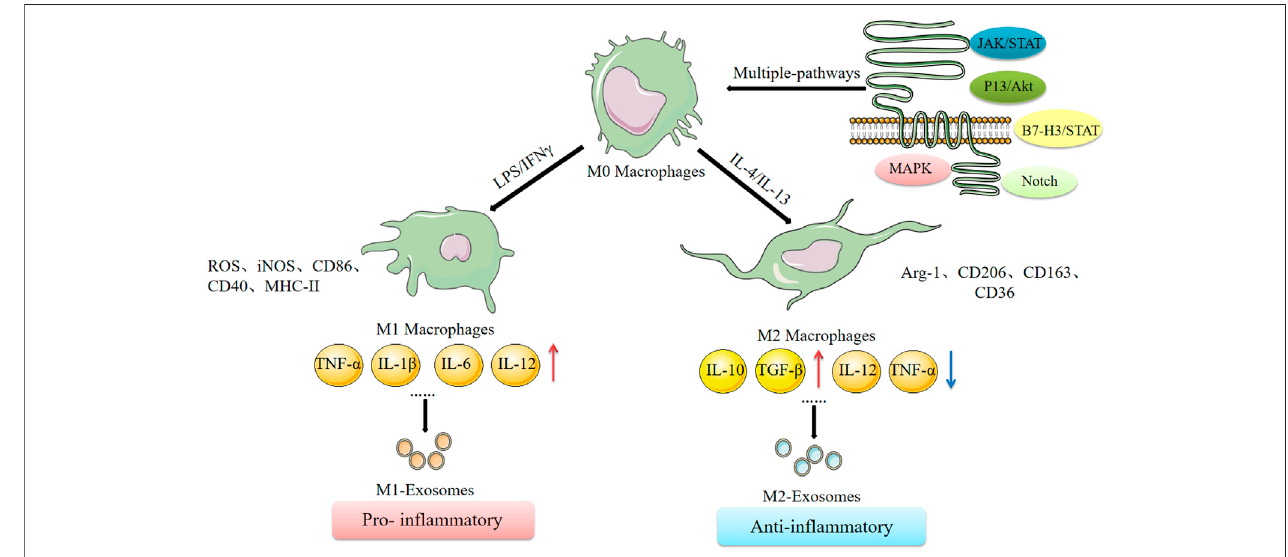
FIGURE 2 | Macrophage polarization and its related